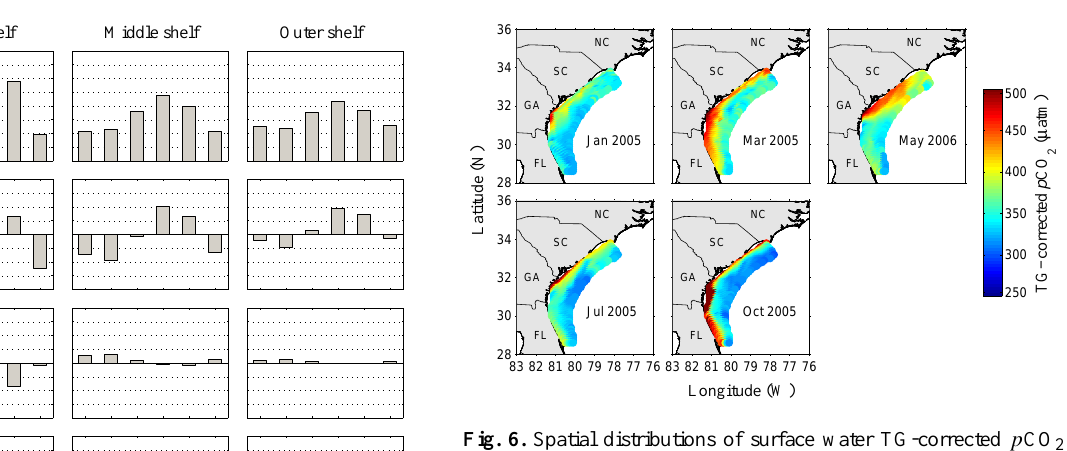
Fig. 6. Spatial distributions of surface water TG-corrected p CO 2 in the South Atlantic Bight in all sampling months except Decem- ber 2005. Due to a lack of DIC data, spatial distribution of TG- corrected p CO 2 in December 2005 is not presented. The colored contours are from triangle-based liner